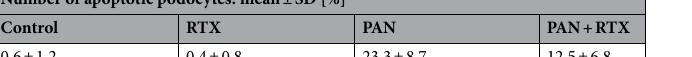
Number of apoptotic podocytes: mean ± SD [%]